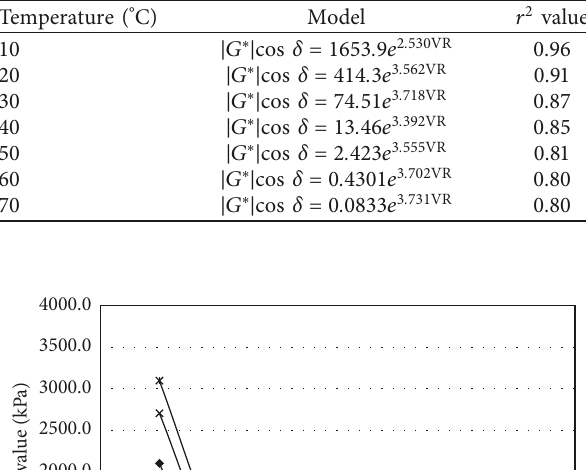
Table 7: Relationship between sawdust mastic (1.78Hz).